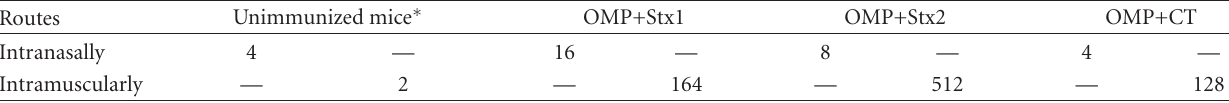
Table 1: SBA in groups of mice after prime i.n. and boost i.m. with meningococcal OMP+Stx1 or OMP+Stx2 or OMP+CT. Routes Intramuscularly 128 ∗ Normal serum from neonatal unimmunized mice or adult